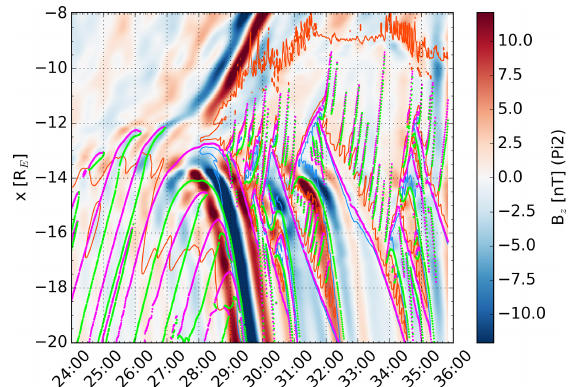
Figure 7. The color shows variations in the Pi2 window ( T = 40– 150s) of the z component of the magnetic field as a function of x and time in minutes after the beginning of the simulation (MM:SS). Magenta and green dots show the locations of the X and O points, respectively. The ± 400kms − 1 contours are indicated with the or- ange and blue